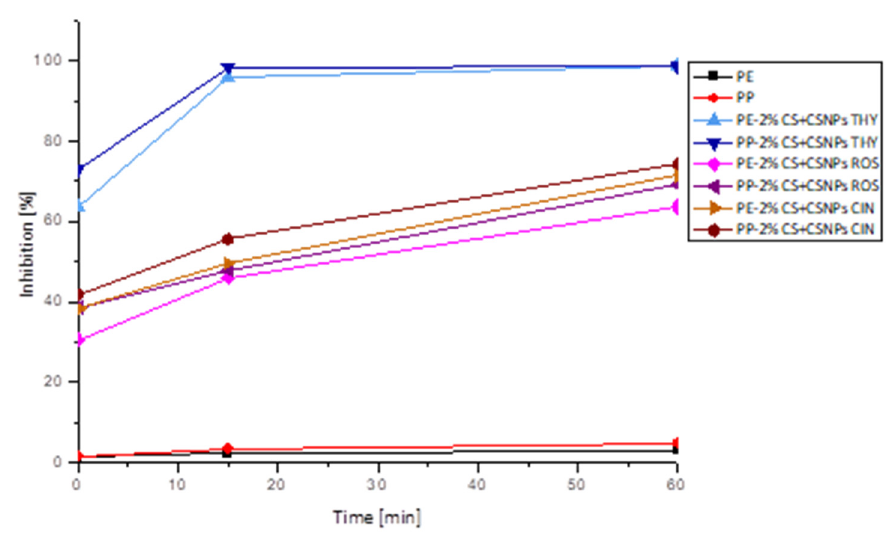
Figure 7. Antioxidative activity of reference PE and PP and ultraviolet (UV) / ozone-activated PE and PP foils, coated with 2% chitosan and chitosan nanoparticles with incorporated thyme / rosemary / cinnamon extract.